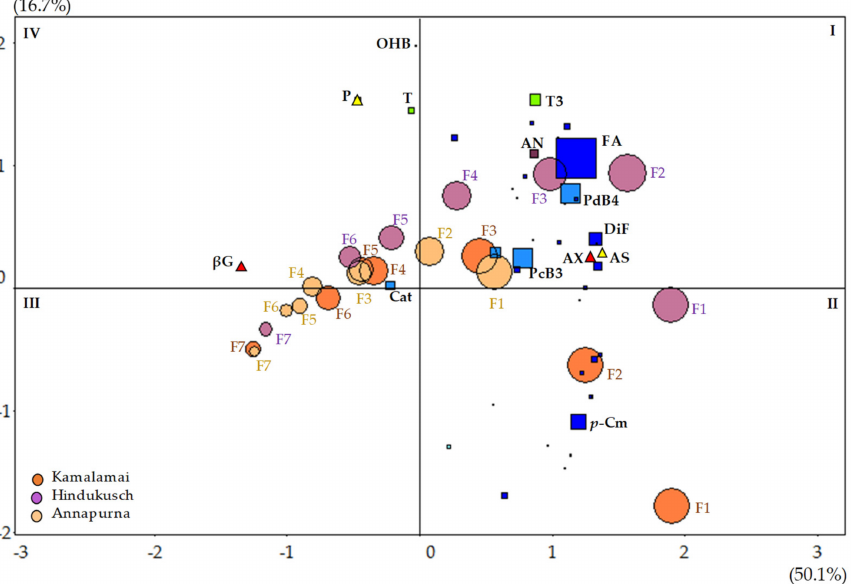
Figure 6. Biplot of the Principal Component Analysis of ash, protein, dietary fiber and 60 bioac- tive compounds in seven sequential pearling fractions in three food barley genotypes. The size of the squares is proportional to each phenolic compound content; Circle size is proportional to total antioxidant capacity. F: fraction; AS: Ash; P: Protein; β G: β -glucans; AX: arabinoxylans; T: tocopherols; T3: tocotrienols. The following eight main phenolic compounds are also labeled: FA: bound ferulic acid; p -Cm: bound p -coumaric acid; DiF: bound diferulic acid; Cat: catechins; OHB: m - or o -hydroxybenzoic acid; PcB3: procyanindin B3, PdB4: prodelfinidin B4; Light blue squares: flavone glycosides; AN: total anthocyanins.